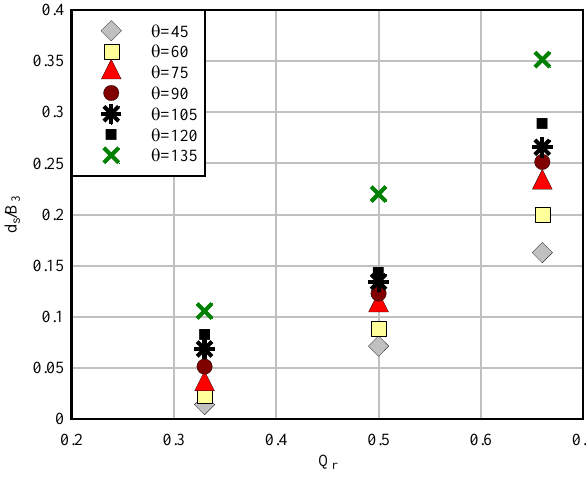
Figure 14. Q r vs. d s / B 3 for different θ.